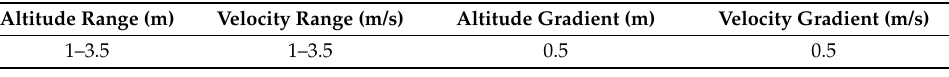
Table 2. Flight parameters of the UAV used for plant